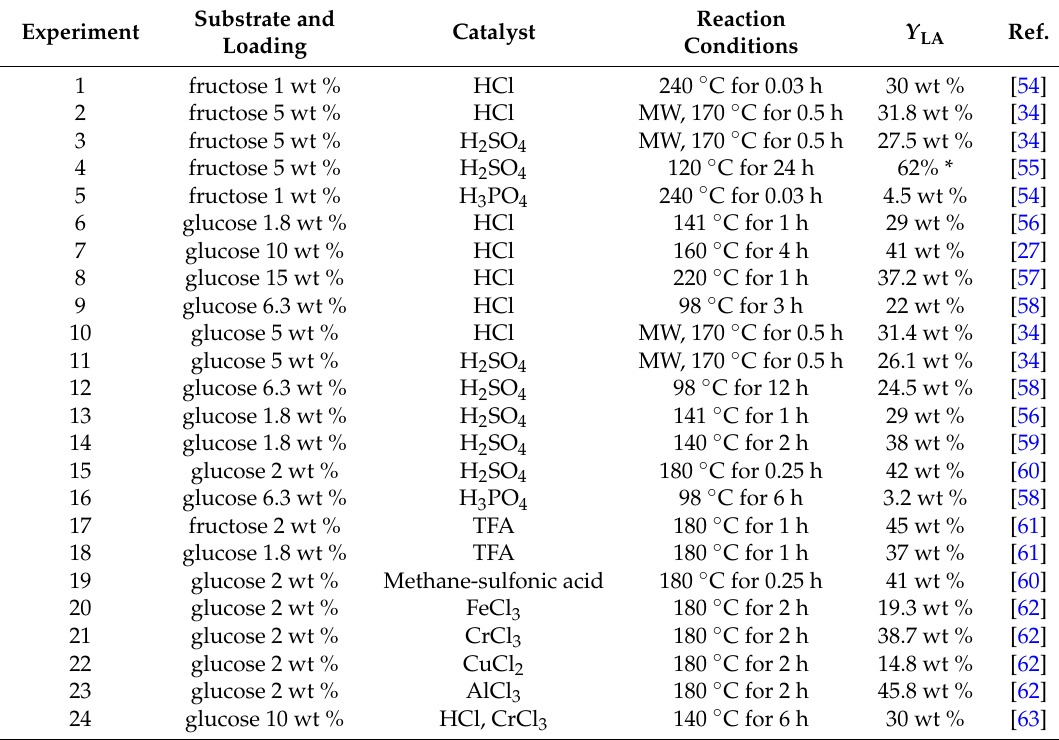
Table 2. C 6 sugars conversion in water in the presence of homogeneous catalysts: reaction conditions. Substrate and Experiment Catalyst Loading